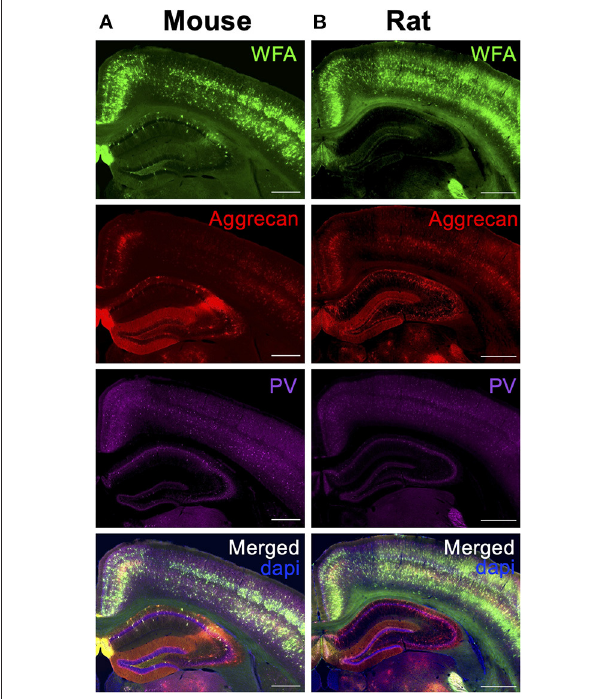
FIGURE 7 | Differences in hippocampal PNN labeling between species. Coronal sections of the dorsal hippocampus for wild type (A) mouse and (B) rats were labeled for PNN glycans (WFA, green ) and PNN CSPGs (aggrecan, red ) and co-localized with GABAergic Parvalbumin (PV, purple ) neurons. Scale: